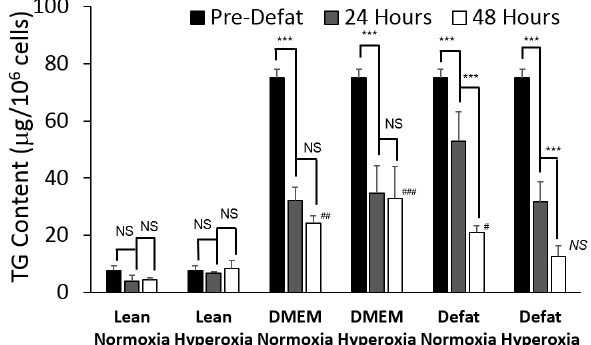
Figure 2. Effect of defatting condition and duration on remaining triglyceride content in steatotic HepG2s. HepG2s were made steatotic by pre-incubation with free fatty acids for two days. Then, the cells were switched to basal medium with no fatty acids (DMEM), or DMEM + defatting cocktail. In each case, defatting was performed under normoxic (21% O 2 v/v ) or hyperoxic (90% O 2 v/v ). Lean controls consisted of HepG2 cells that were never made steatotic. Data shown represent the amount of triglyceride normalized to cell number in each well, measured before defatting (pre-defat), after 24 h, and after 48 h of defatting. Values are expressed as averages ± S.E.M. for n = 3 replicates. ***: p <0.001. NS: not significantly different. Comparisons of defatted vs. lean groups: ### p <0.001; ## p <0.01; # p <0.05; NS : not significantly different.